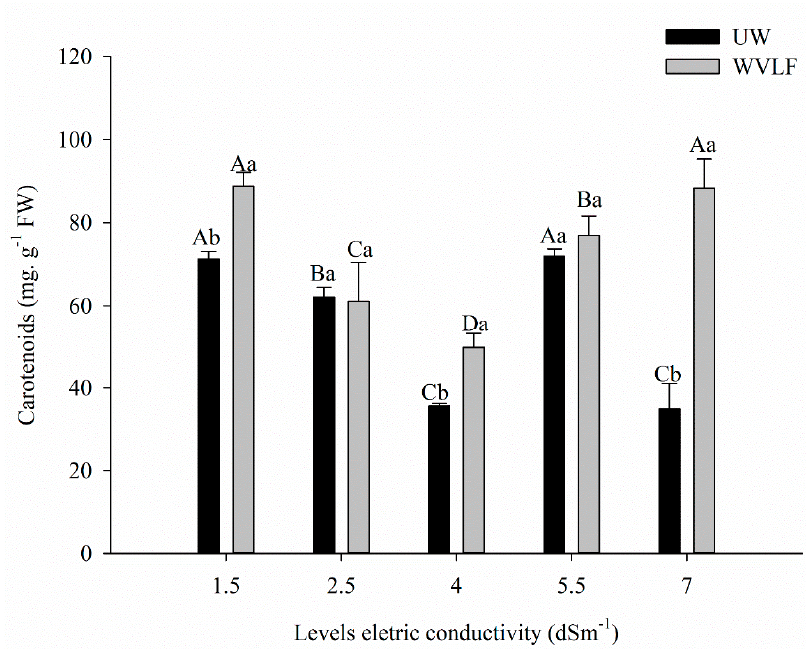
Figure 3. Carotenoid contents for different levels of fertigation, in response to irrigation management with electromagnetically treated (WVLF) and untreated water (UW). Means followed by the same letter (lowercase compares the type of water and uppercase compares the salinity doses) do not differ statistically ( p < 0.05) according to the Tukey test. Error bars indicate the standard deviation of the mean of four replicates ( n = 4).